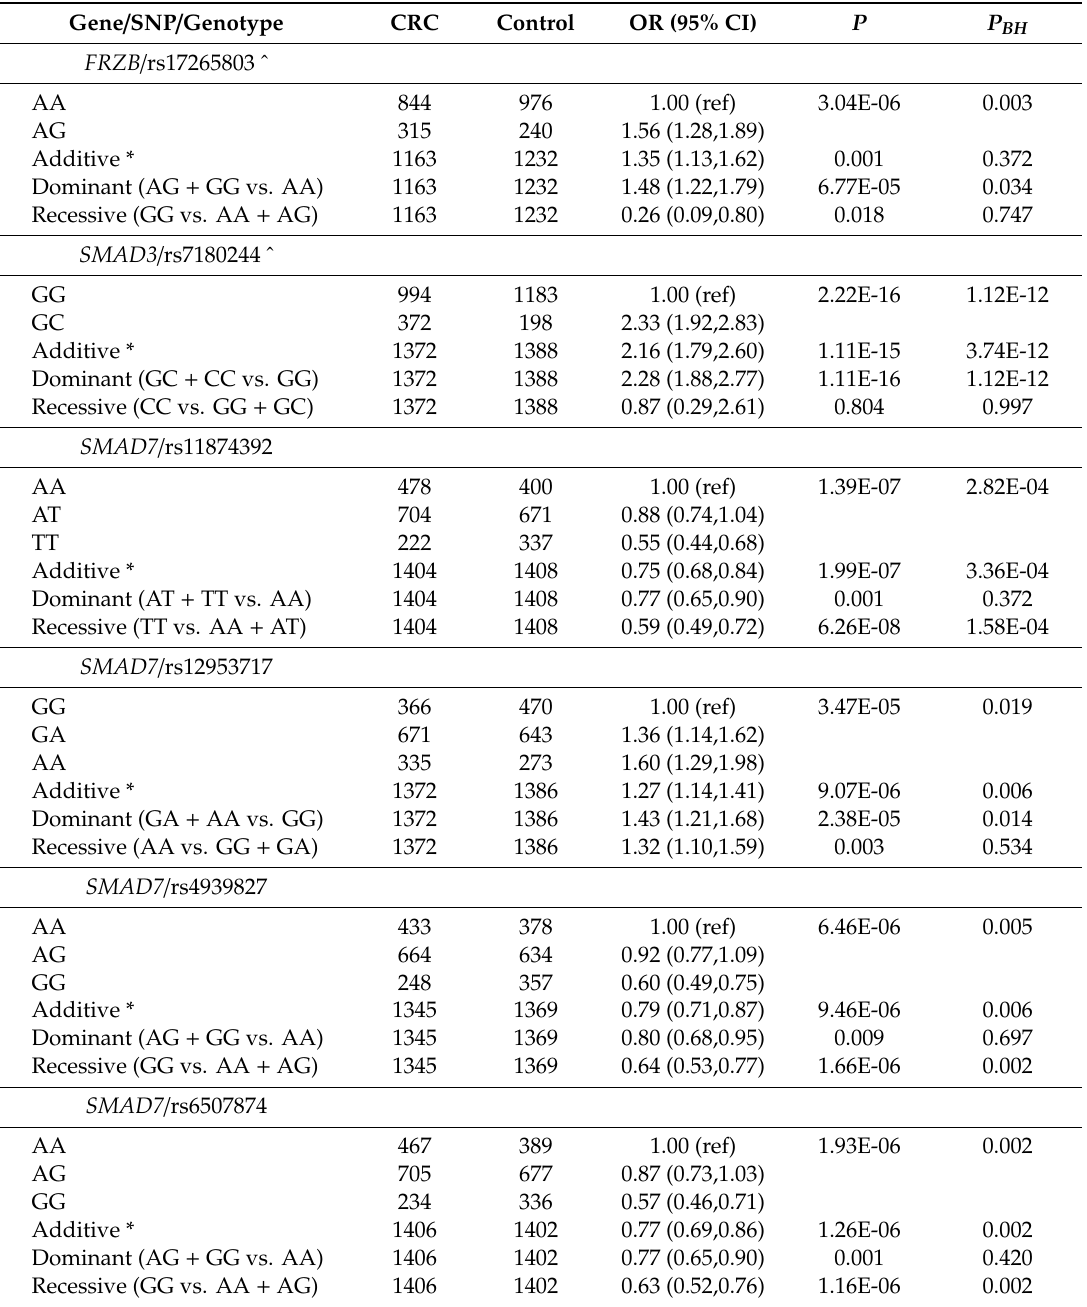
Table 3. Single Nucleotide Polymorphisms (SNPs) statistically significantly associated with colorectal cancer (CRC) risk after Benjamini–Hochberg (BH) multiple testing correction, the EPIC study,